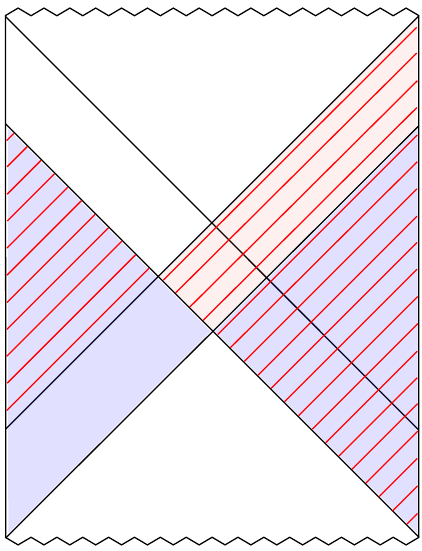
and N (cid:48) are shaded blue, while M and M (cid:48) are filled R R R R = N (cid:54) = M , but M (cid:48) since the inclusion breaks the left- L L R R ⊂ M = ⇒ M (cid:48) ⊂ N (cid:48) . R R R R ⊂ M , i.e., the portion of M not contained in R R R